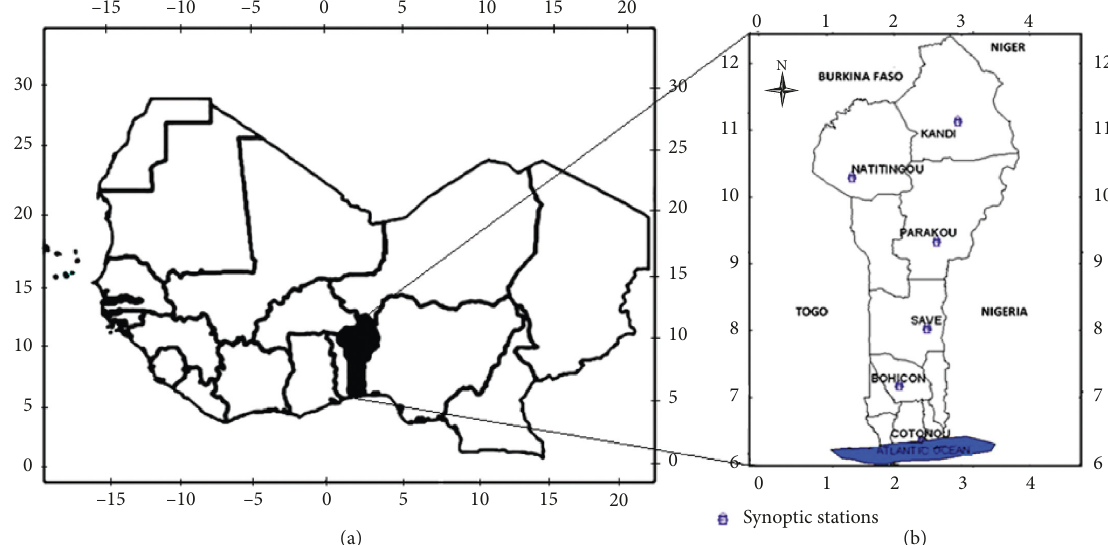
Figure 1: Study sites location: (a) B´enin location in West Africa; (b) synoptic station locations in